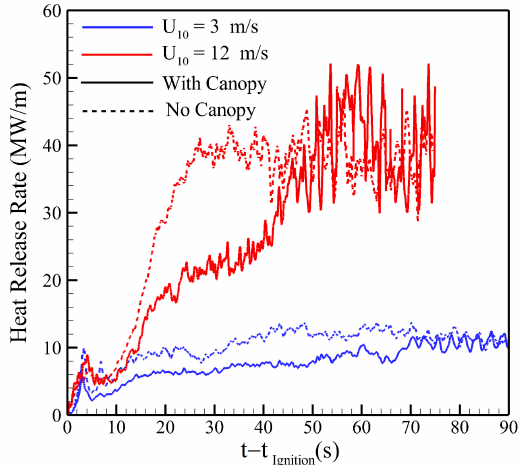
Figure 16. Time evolution of the heat release rate obtained from Equation (2) for U 10 = 3 m/s and 12 m/s in the case of fire spread downstream of a canopy, compared to the case of fire spread obtained for the same simulation conditions but without a canopy.